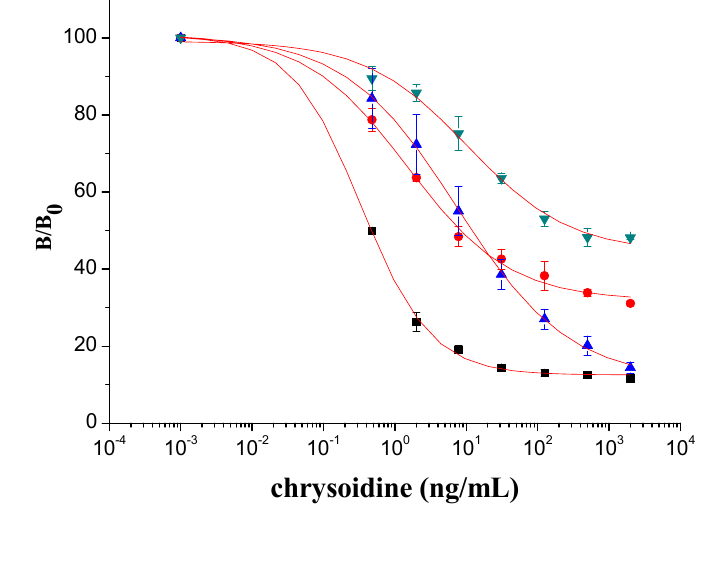
Figure 3. icELISA standard curves for chrysoidine with heterogeneous combinations of coating antigen and antibody. Data represented in mean ± SD (standard deviation) from three assays. ■ combination of antibody 2 and Hapten 1-OVA; ● combination of antibody 1 and Hapten 2-OVA; ▲ combination of antibody 1 and Hapten 1-OVA; ▼ combination of antibody 2 and Hapten